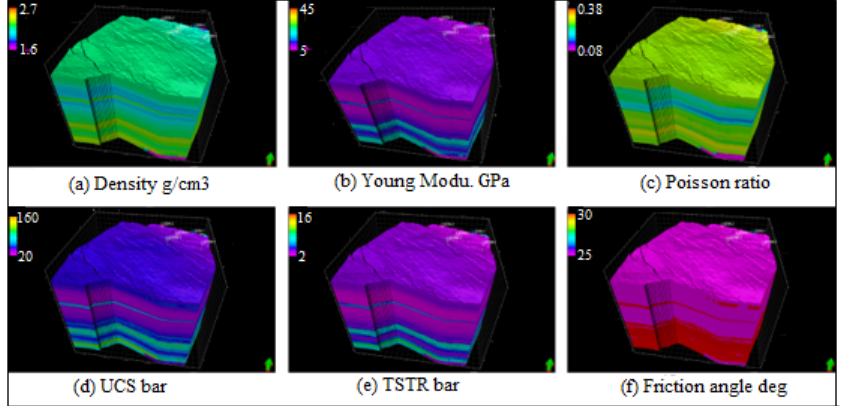
Figure 9. Rock properties calculated from seismic inversion results: ( a ) density (g/cm 3 ), ( b ) Young’s modulus (GPa), ( c ) Poisson ratio, ( d ) UCS (bar), ( e ) resistance to tension (bar), ( f ) friction region (deg).